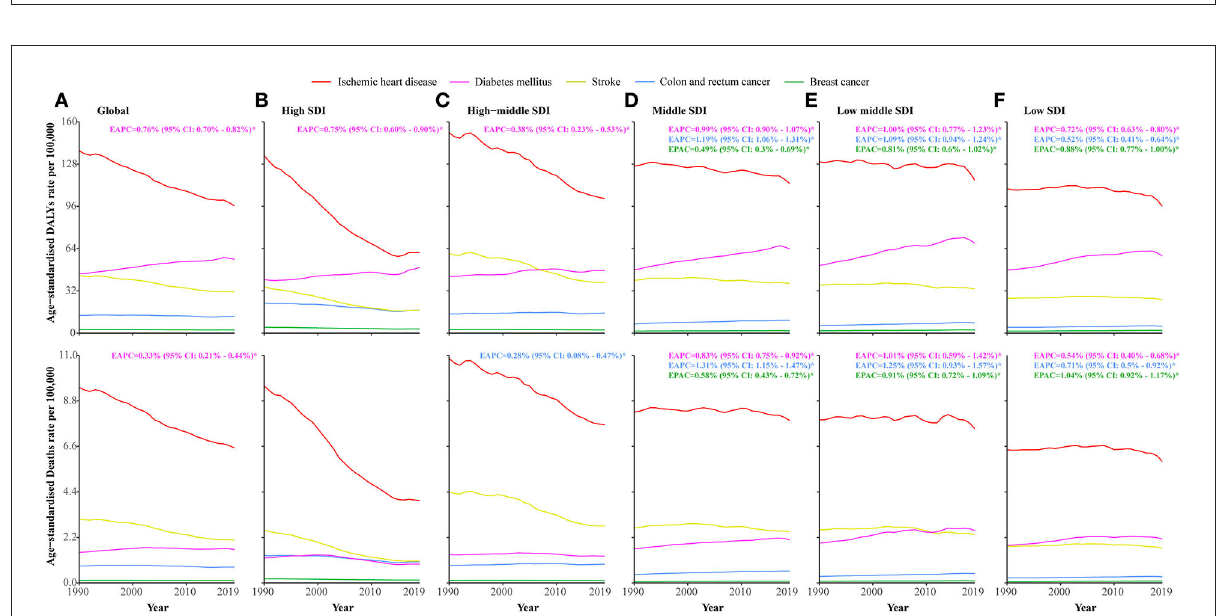
FIGURE2 Age-standardized DALYs and death rates of specific causes attributable to low physical activity amongst SDI quintiles from 1990 to 2019. (A) Age-standardized DALYs and death rates of each specific cause attributable to low physical activity worldwide. (B) Age-standardized DALYs and death rates of each specific cause attributable to low physical activity in high SDI countries. (C) Age-standardized DALYs and death rates of each specific cause attributable to low physical activity in higher-middle SDI countries. (D) Age-standardized DALYs and death rates of each specific cause attributable to low physical activity in middle SDI countries. (E) Age-standardized DALYs and death rates of each specific cause attributable to low physical activity in lower-middle SDI countries. (F) Age-standardized DALYs and death rates of each specific cause attributable to low physical activity in low SDI